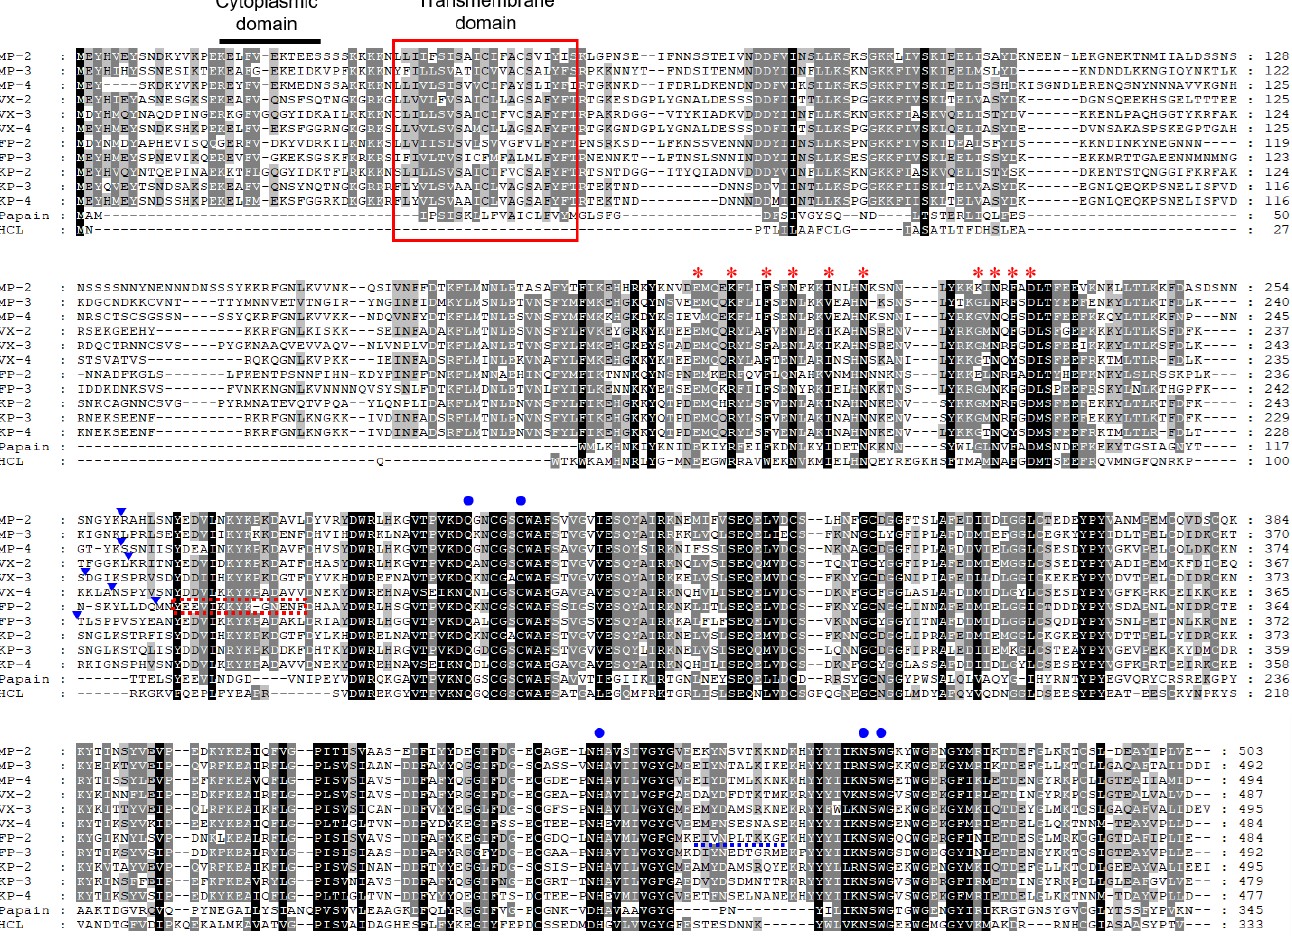
Figure 1. Sequence alignment of MPs and FP-2/FP-3 subfamily enzymes. The deduced amino acid sequences of MPs, VXs, FPs, KPs, papain, and human cathepsin L (HCL) were aligned. Dashes represent gaps introduced to maximize alignment. The predicted cytoplasmic domain is represented as a bold black bar on the sequences. The predicted transmembrane domain is boxed in red. Amino acid residues corresponding to ERFNIN and GNFD motifs, which are conserved pro-domain motifs of papain-like family enzymes, are marked with red asterisks. Blue circles indicate conserved residues for the active site formation. The predicted refolding motif of FP-2 is shown as a red dotted box. The hemoglobin-binding motif is underlined as a blue dotted line. The positions of experimentally confirmed or predicted mature domain processing sites are indicated by blue arrows. Percentage of identity among the sequences is represented as shading: black (>88%), dark grey (75–88%), light grey (37–75%), and no shading (<37%).